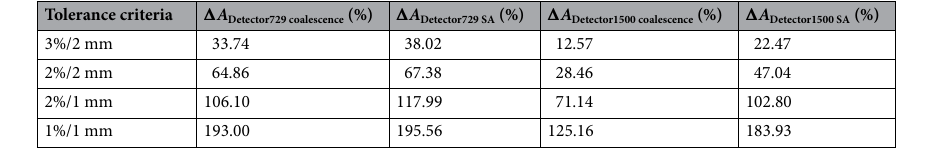
Table 1. Difference between upper action limit (UAL) and lower action limit (LAL) in both detectors.